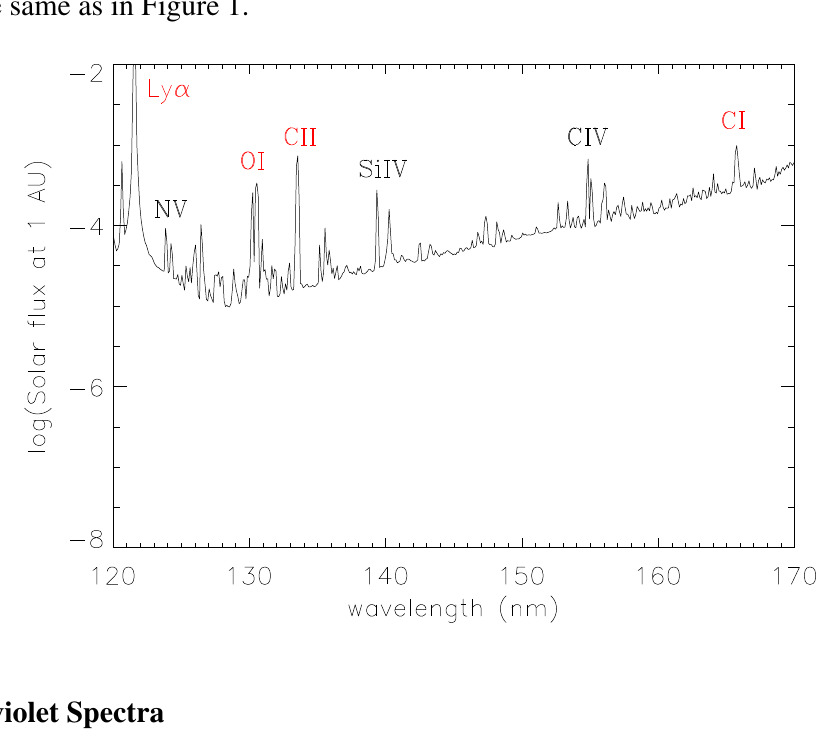
Table 1. For IUE, SW and LW refer to short and long wavelength spectrographs, respectively, and for GALEX, FUV and NUV refer to the far-UV and near-UV spectral